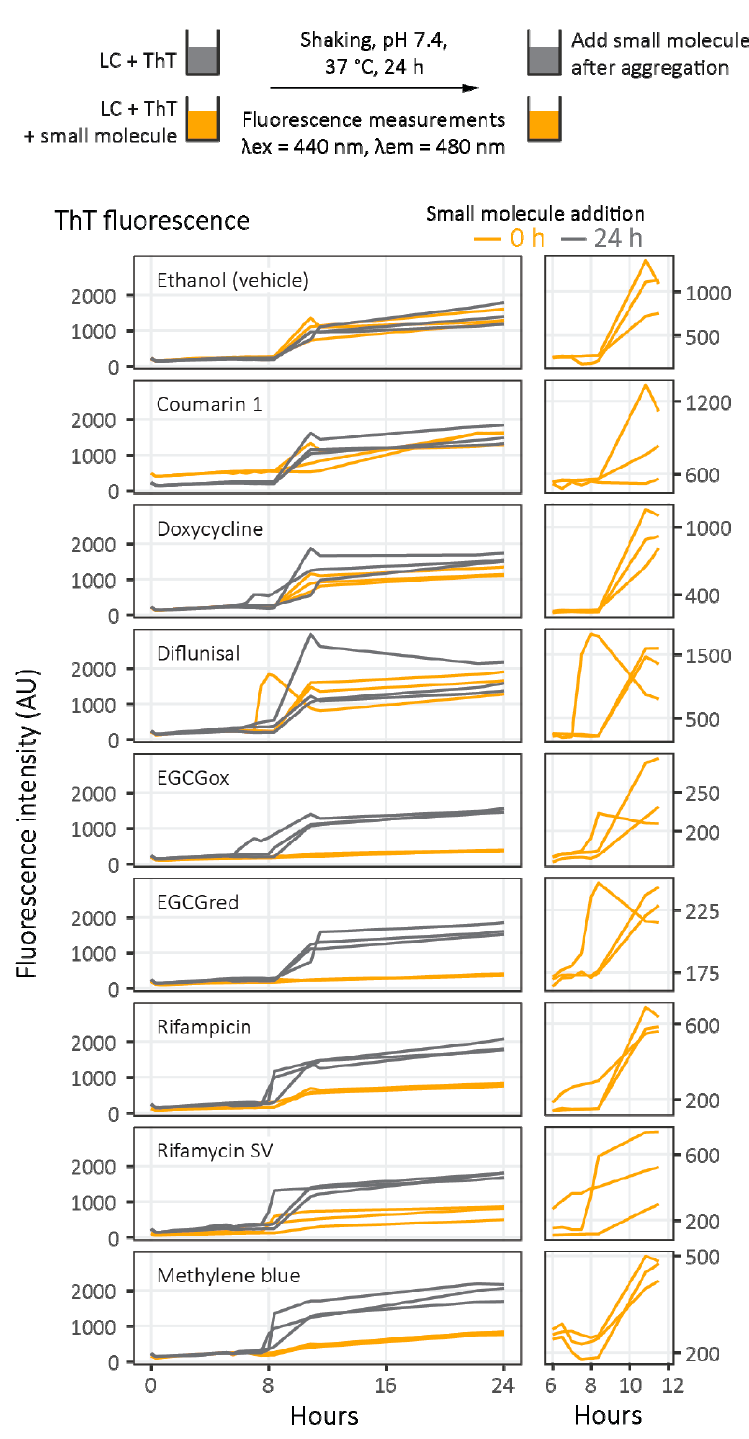
Figure 6. Aggregation of LC V L -domains measured by thioflavin T fluorescence. Experimental design is shown at the top. After 24 h of aggregation monitored by ThT fluorescence, the effect of small-molecule addition to pre-formed fibrils on ThT fluorescence was measured (Figure 7, below), and the amount of soluble and aggregated LC is quantitated by the filter trap assay (Figure 8, below). Orange traces represent fluorescence intensity changes ( n = 3 wells) in the presence of small molecules, and grey traces represent control wells where small molecules were added after 24 h ( n = 3 wells). Panels on the right show the detail of the time period where aggregation